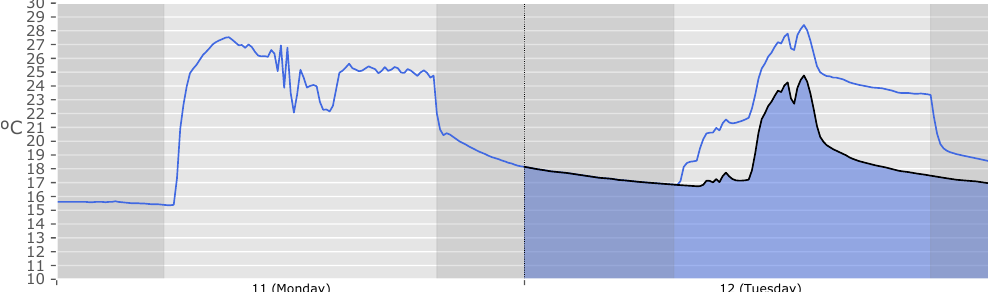
Figure 2. Measured temperature (blue line) and free oscillation temperature (black line) of thermal zone 14. Office building, School of Architecture (University of Navarra), 11–12 December 2017.